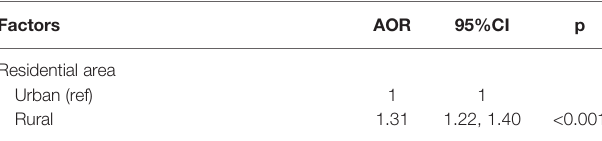
TABLE 4 | Predictors for non-utilization of kidney disease test in South Korean diabetic patients: AOR and 95%